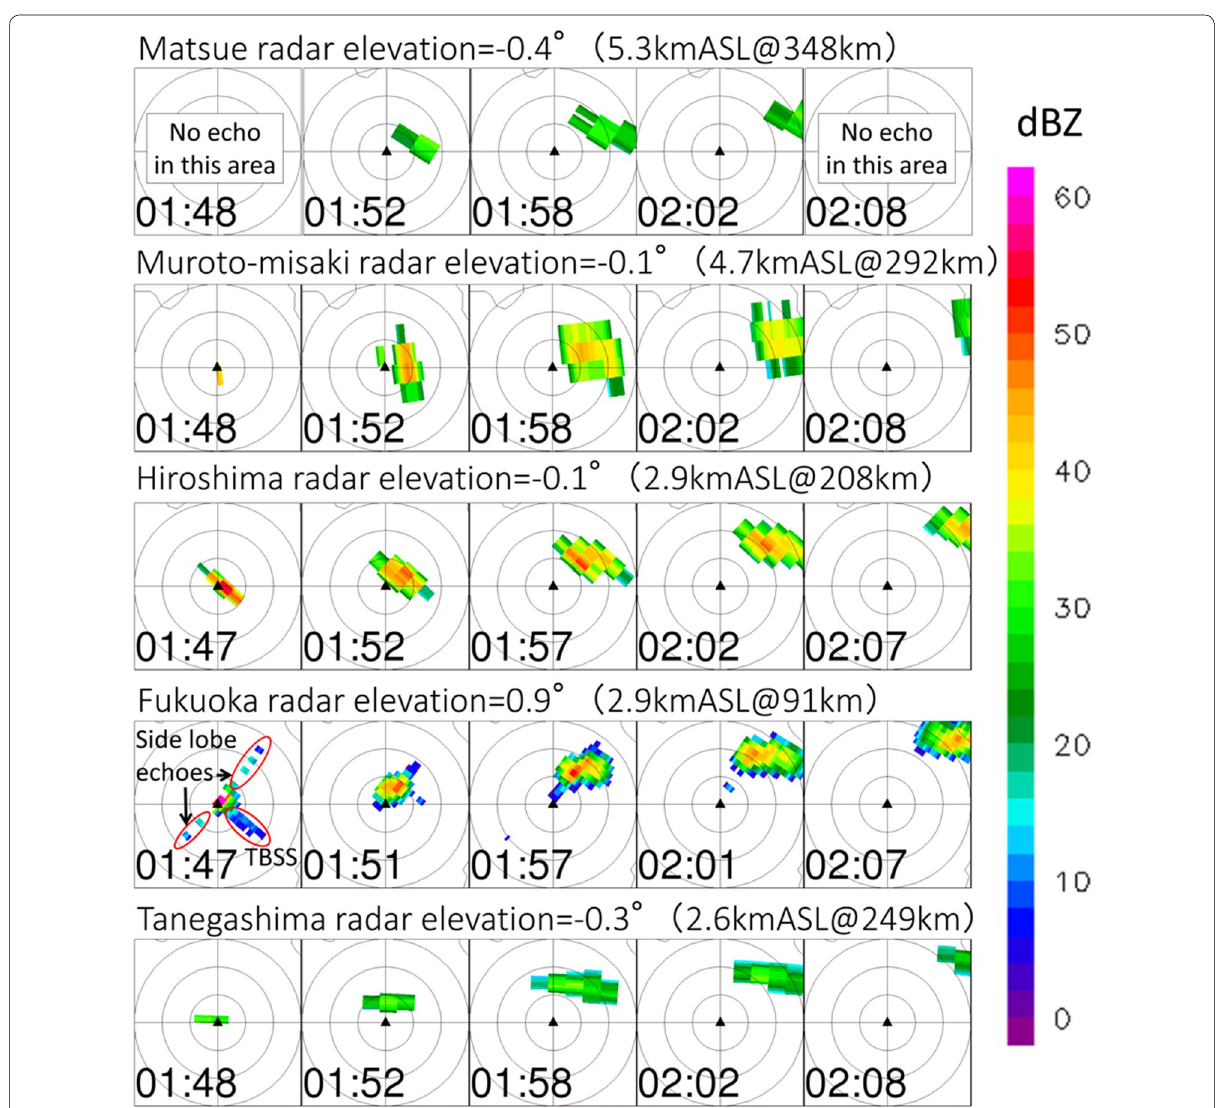
Fig. 2 Eruption cloud echoes observed by JMA-RDN from eruption time (1:46 JST) to 2:10 JST, October 8, 2016. Concentric circles represent 5, 10 and 15 km from the crater of Mt. Aso ( ▲